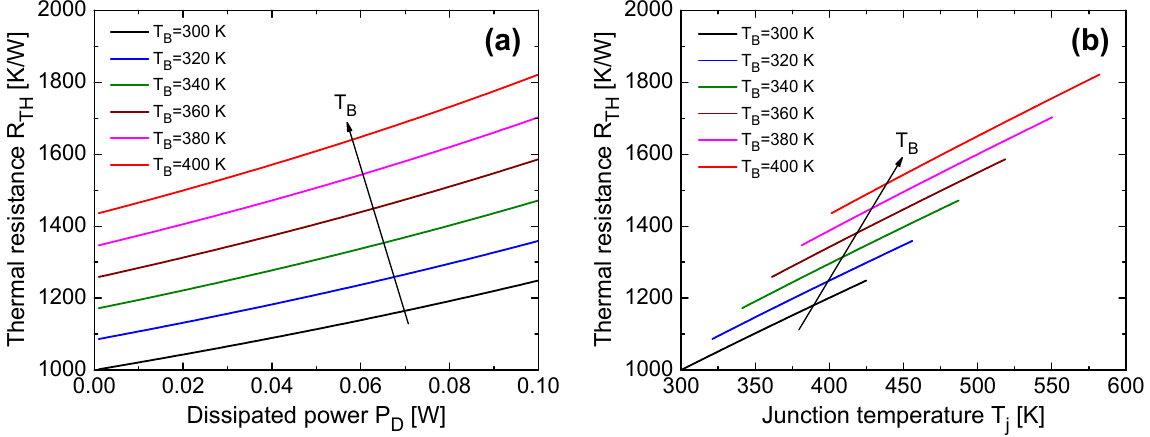
Figure 1. Thermal resistance R TH as a function of ( a ) dissipated power P D and ( b ) junction tempera- ture T j at T B = 300, 320, 340, 360, 380, 400 K.